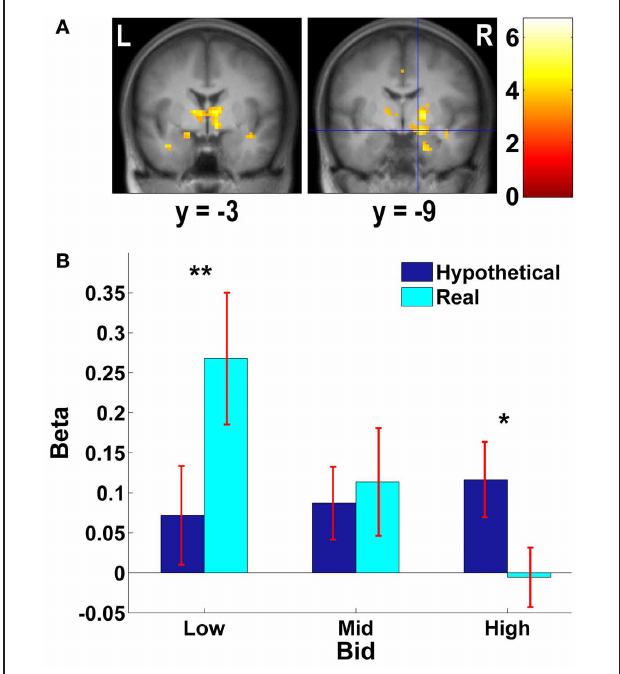
FIGURE 3 | Frontal areas exhibiting higher negative correlation with real bids than hypothetical bids. (A) Deactivations in the [real × bid − hypothetical × bid] contrast ( p < 0 . 001, uncorrected; threshold k ≥ 5 voxels). The color bar on the right indicates the t -score. (B) Average response in the OFC area to different levels of bids by trial type. The OFC mask was defined as a vmPFC area (peak at x = 21 , y = 27 , z = − 18) identified in the [real × bid - hypothetical × bid] contrast [the area with crosshairs shown in the right panel of (A) ]. β values extracted from this OFC mask. ∗∗ p = 0 . 016, no asterisk = not significant, paired two-sample t -test.